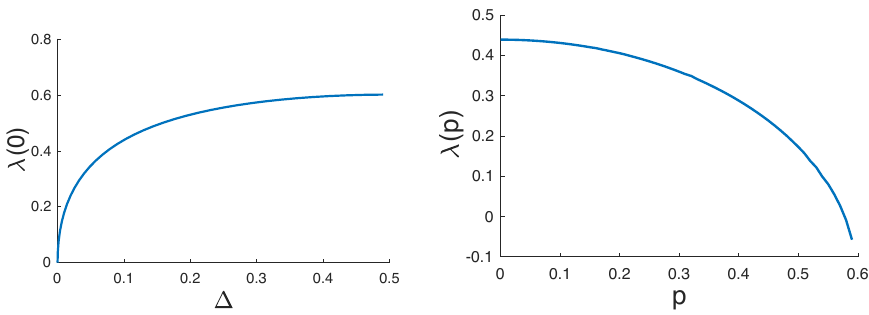
Figure 13 . Left: the chaos exponent (cid:21) L (0) as a function of (cid:1) for the two-dimensional supersym- metric theory. Middle: the function (cid:21) L ( p ) for (cid:1) = 0 : 1. The function is symmetric in p it becomes complex just beyond where the curve